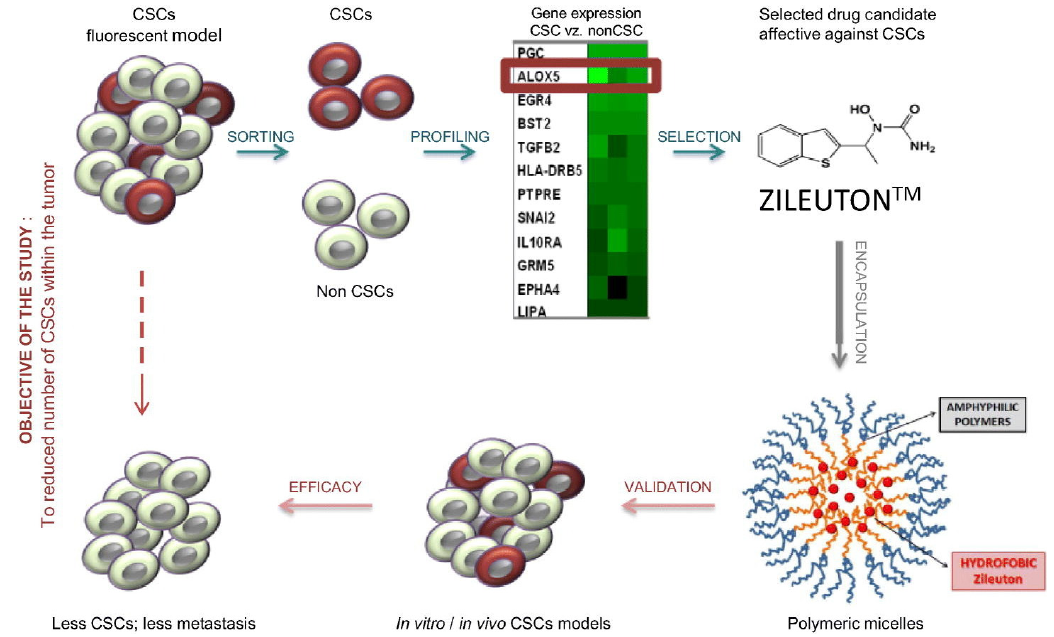
Figure 3. Gener et al. developed and synthesized polymeric micelles loaded with Zileuton™, a potent inhibitor of ALOX5 in cancer stem cells (CSCs), which were chosen as a therapeutic target candidate based on high-throughput screening data. Its great potential for CSC treatment was subsequently demonstrated in vitro and in vivo in breast CSC fluorescent models. PM-Zileuton™ shows strong reduction in the amount of intratumoral CSCs and, further, of blood circulating CSCs in vivo [82] .